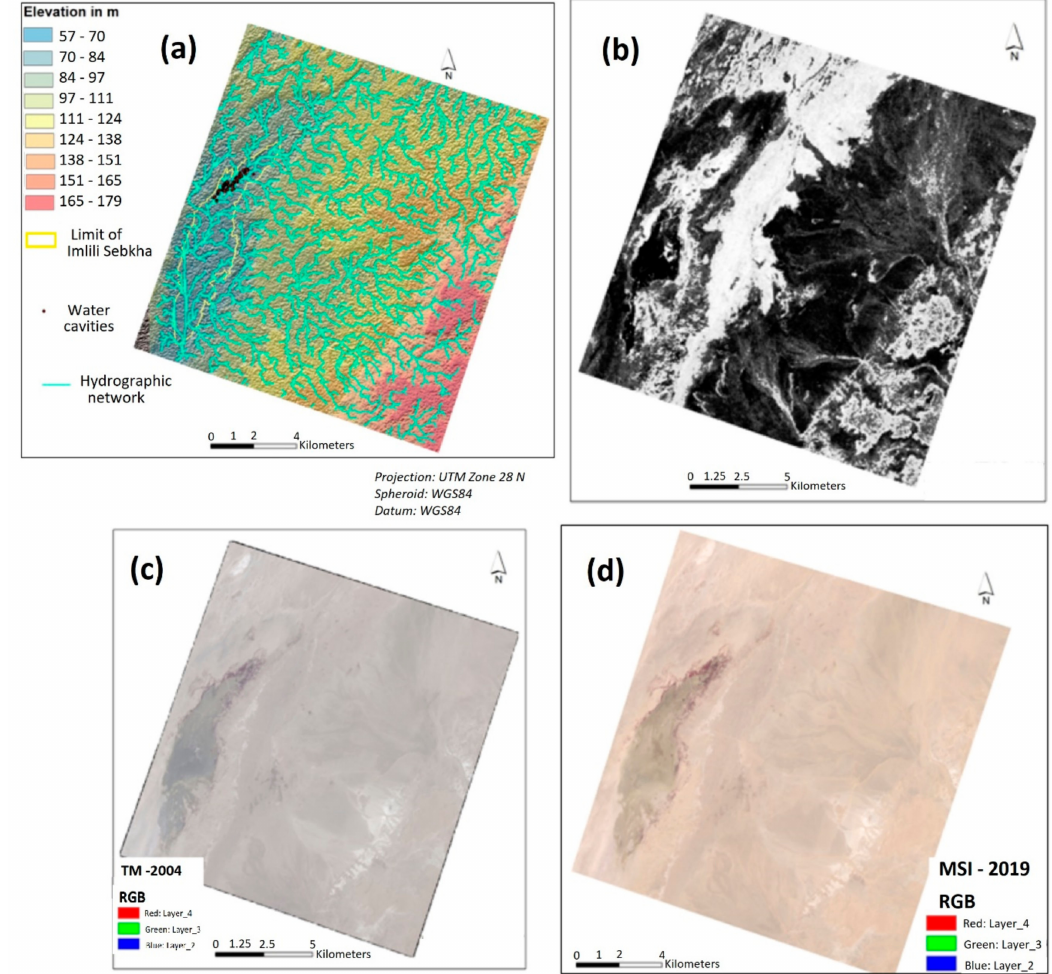
Figure 3. ( a ) Digital Elevation Model (DEM) with a hydrologic network and water cavities, ( b ) Sentinel-1 C-band (central frequency of 5.404 GHz) Level-1 GRD, ( c ) Landsat Thematic Mapper TM-2004, and ( d ) Sentinel-2 MultiSpectral Instrument (MSI) 2019 used in the